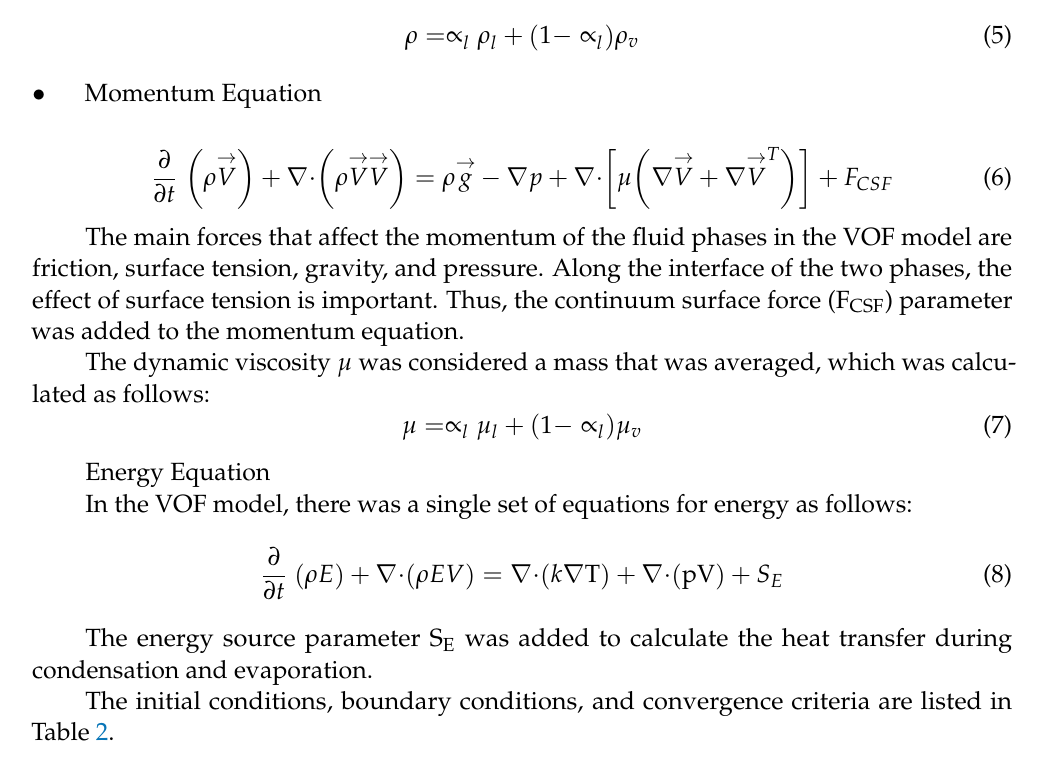
Table 2. The initial conditions, boundary conditions and convergence